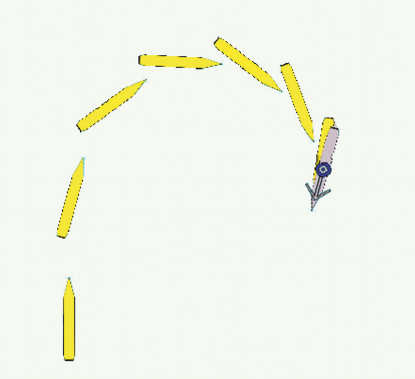
Figure 4: Simulation of sample ships turning performed with the use of the full mission bridge simulator at the Faculty of Navigation, Gdynia Maritime